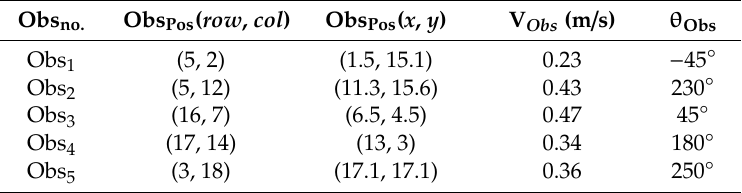
Table 5. Grid-based dynamic environment 2